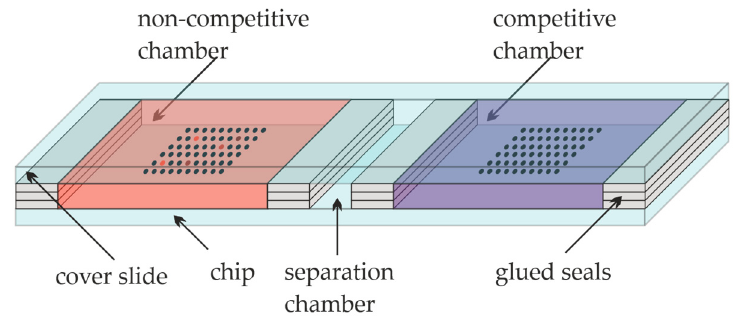
Figure 2. Competition experiment on a microarray slide.